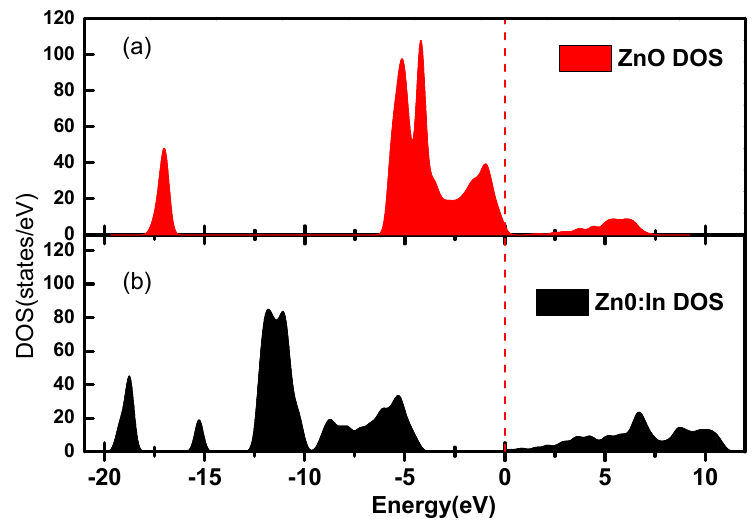
Figure 4. The DOS of ZnO ( a ) and ZnO:In ( b ).